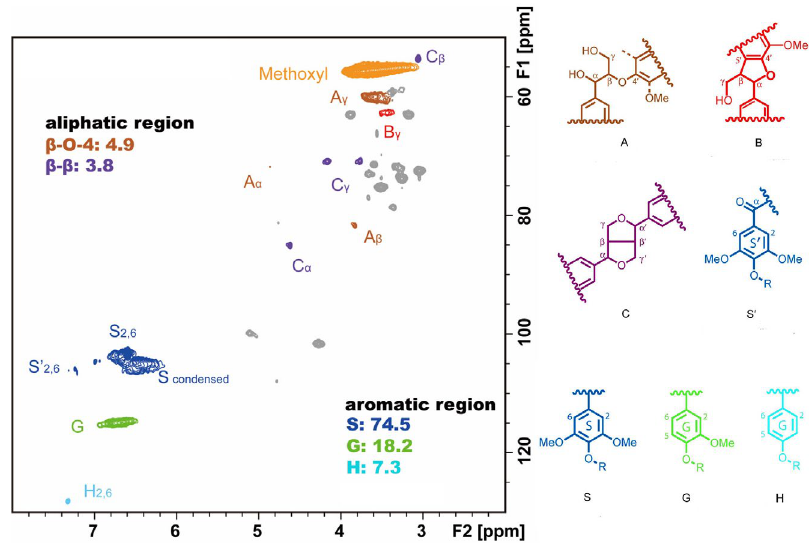
Figure 6. The 2D 1 H- 13 C HSQC spectrum of APSC-AWW lignin , (A) β -O-4 aryl ether linkages with a free- OH at the γ - carbon; (B) phenylcoumarane substructures formed by β - 5 and α -O-4 linkages; (C) resinol substructures formed by β - β, α -O- γ, and γ -O- α linkages; (S’) oxidized syringyl units with a C α ketone or a C α carboxyl group; (S) syringyl units; (G) guaiacyl units; (H) p -hydroxyphenyl units. The abundance of substructures was expressed per 100 aromatic units.